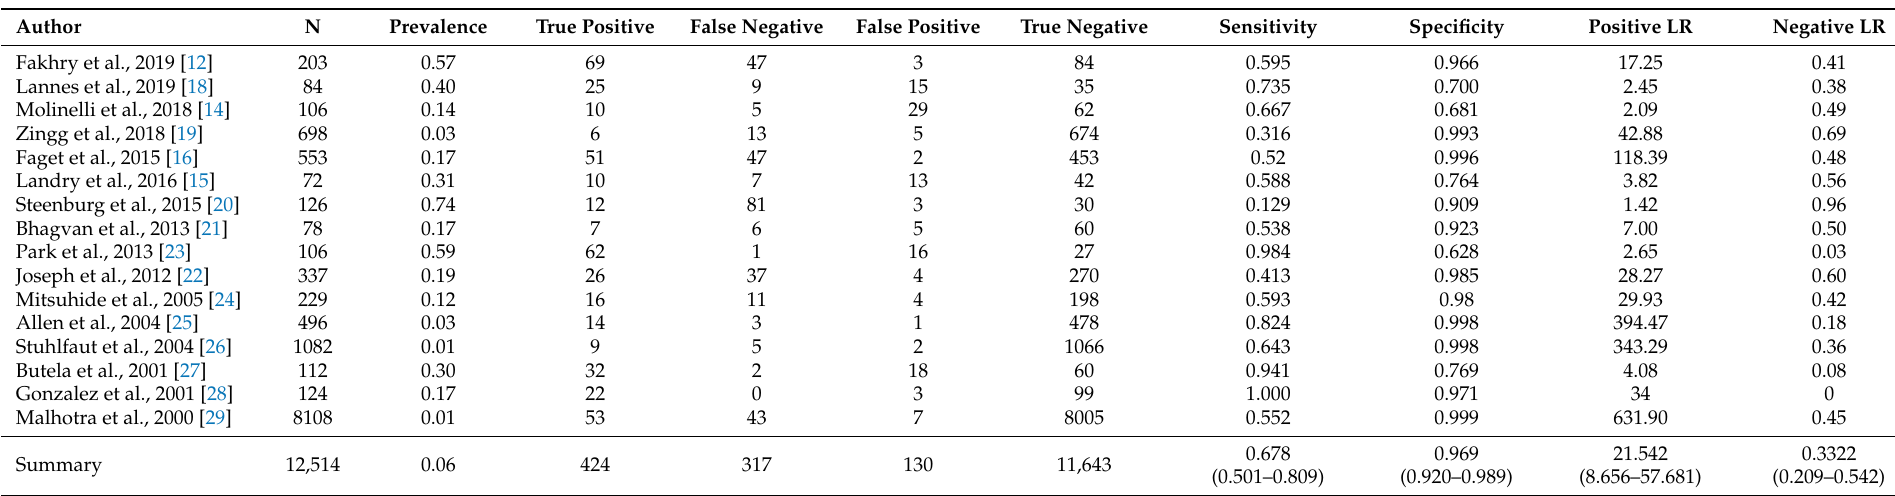
Table 2. Summary data of the included studies with detailed data on the accuracy of computed tomography for the detection of traumatic bowel